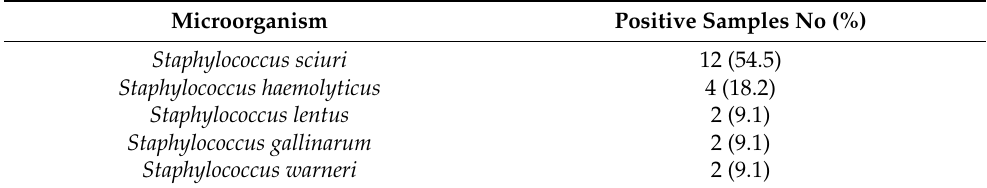
Table 1. Prevalence of coagulase-negative methicillin-resistant Staphylococcus